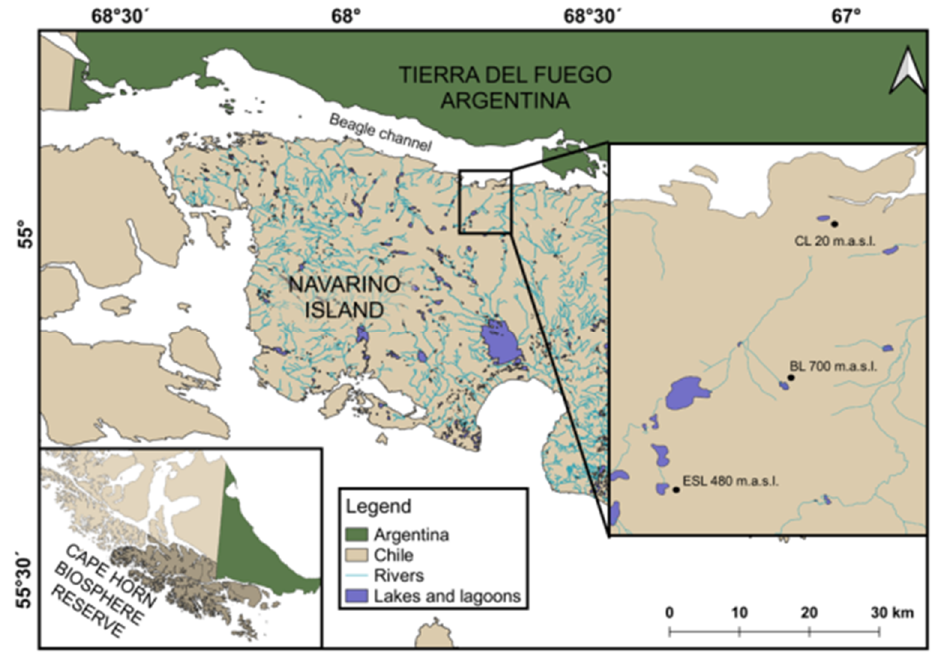
Figure 1. Cape Horn Biosphere Reserve and collection sites on Navarino Island. Collection sites within the Róbalo river watershed are expanded in the inset. CL, Castor Lagoon; ESL, el Salto Lagoon; BL, Bandera Lagoon.